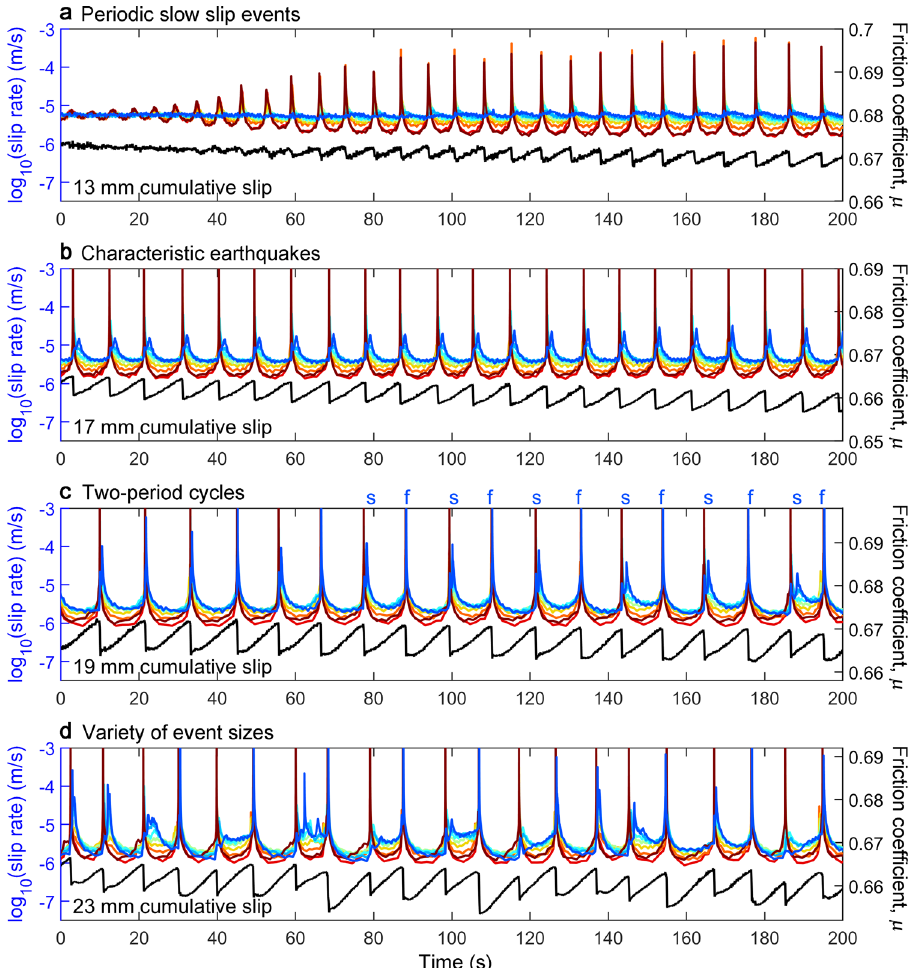
Fig. 2 | Examples of sequences from four displacement intervals showing a progressionfromsimpletocomplex. DatafromtheexperimentofFig.1.Sample- average friction (black) and slip rates (colors) at 8 locations from A1 (red) to A2 (blue)(seeFig.1aforlocations). a SlowslipeventsgrowonA1whileA2slipssteadily (x LP =13mm). b Identical,periodicseismicrupturesonA1withslowlyevolvingslow